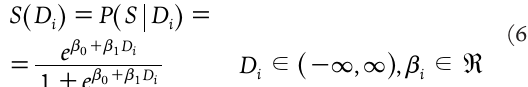
Table 2. Examples of possible mapping operators.